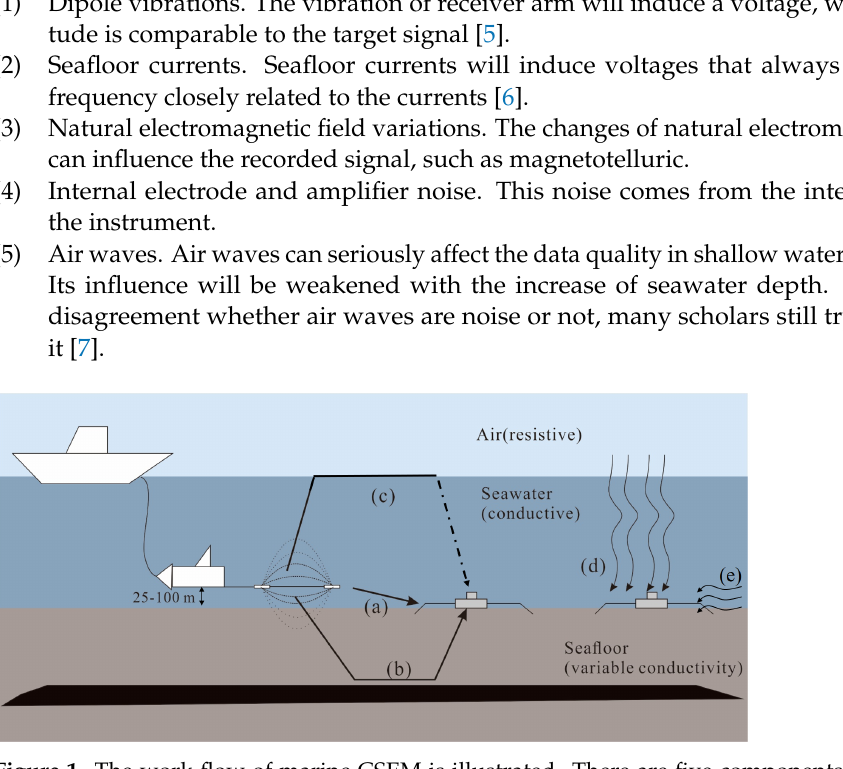
Figure 1. The work flow of marine CSEM is illustrated. There are five components in the signal recorded at the receiver, ( a ) direct wave, ( b ) reflection-refraction wave, ( c ) air wave, ( d ) natural electromagnetic field variations and ( e )